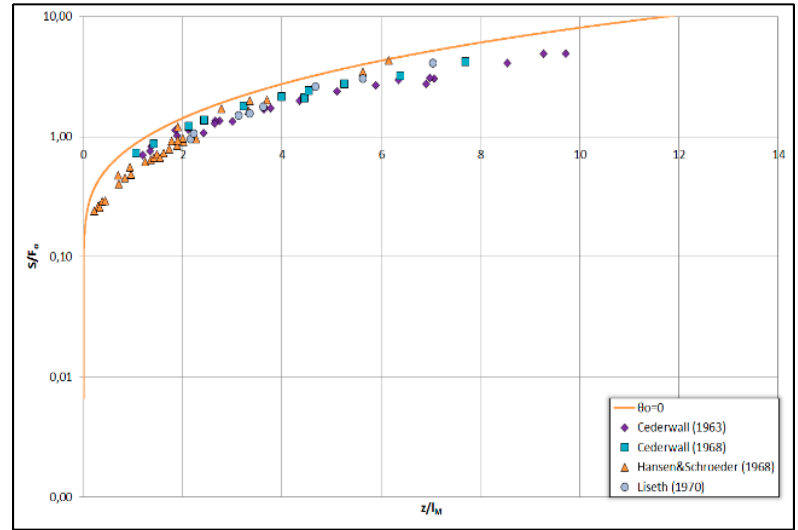
Figure 2. Comparison between model and experimental results regarding the axial dilution S/F o of positively buoyant saline jets.